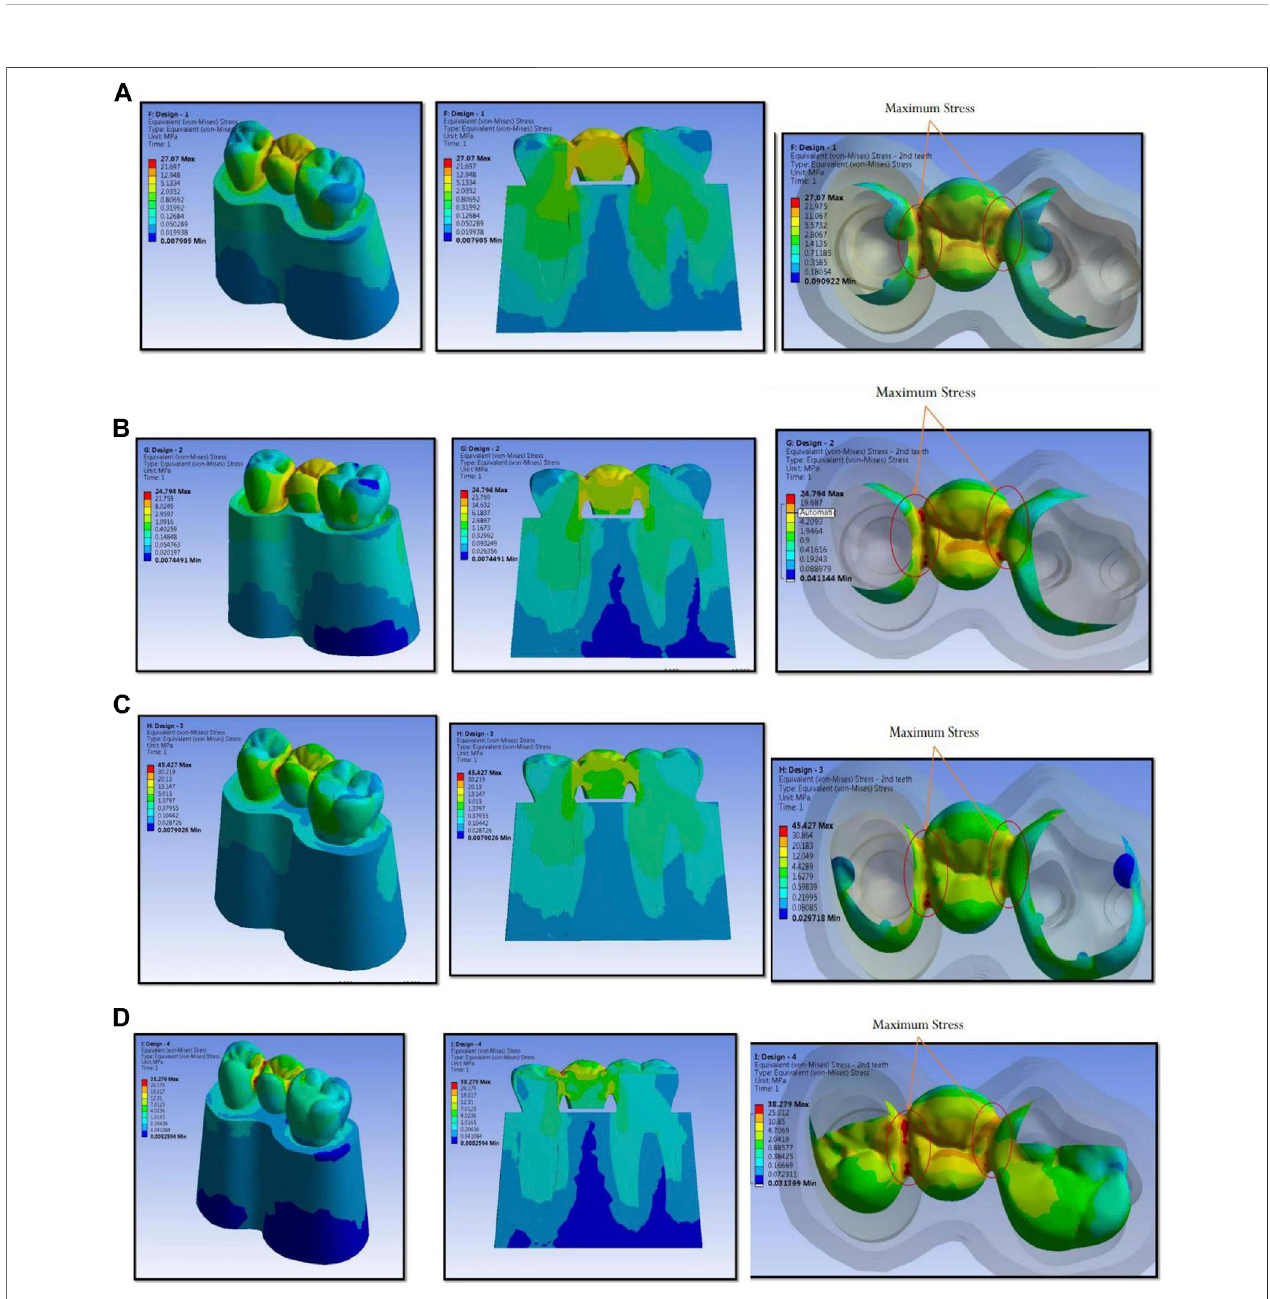
FIGURE 4 | Maximum stress observed is in prosthesis and the magnitude and stress concentration in prosthesis for design 1 (A) , design 2 (B) , design 3 (C) , and design 4 (D) used in fi nite element analysis.